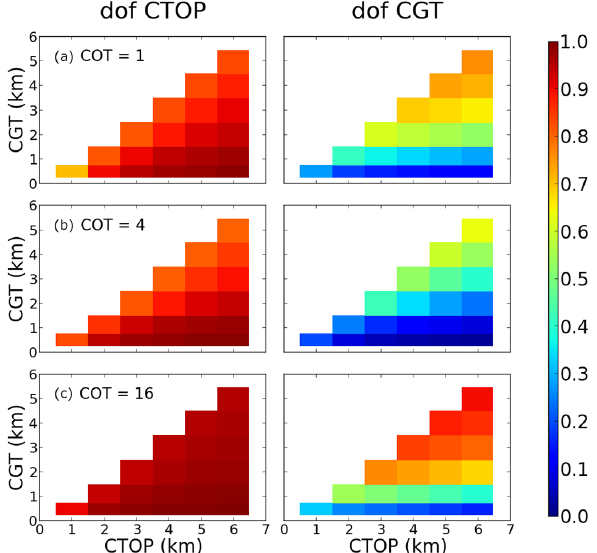
Figure 14. Information content of 3MI A-band for different COTs: (a) COT = 1, (b) COT = 4, (c) COT = 16. Partial DOFs for CTOP (left) and CGT (right).